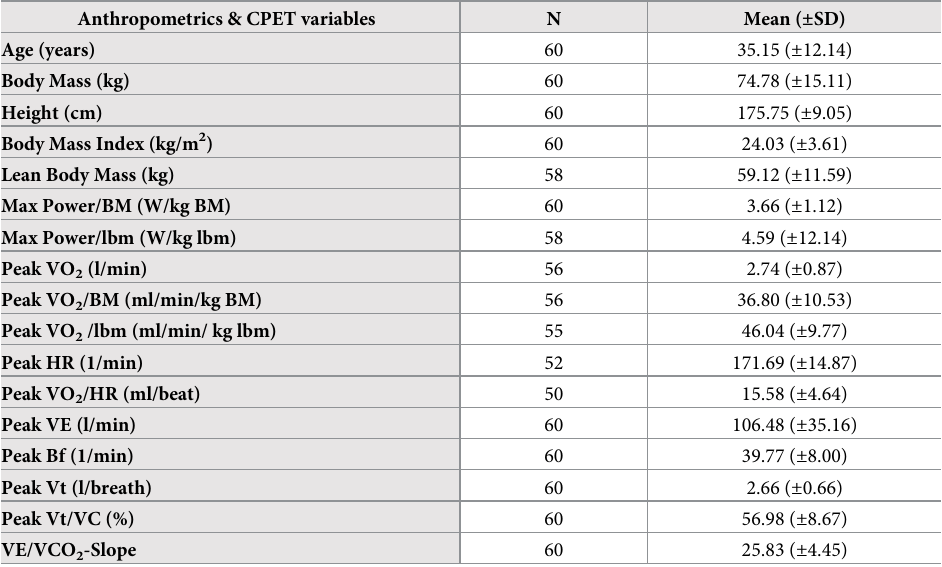
Table 1. Anthropometric and CPET data of study population (N = 60) at t 0 (first examination date). Values are given as mean and standard deviation (SD).